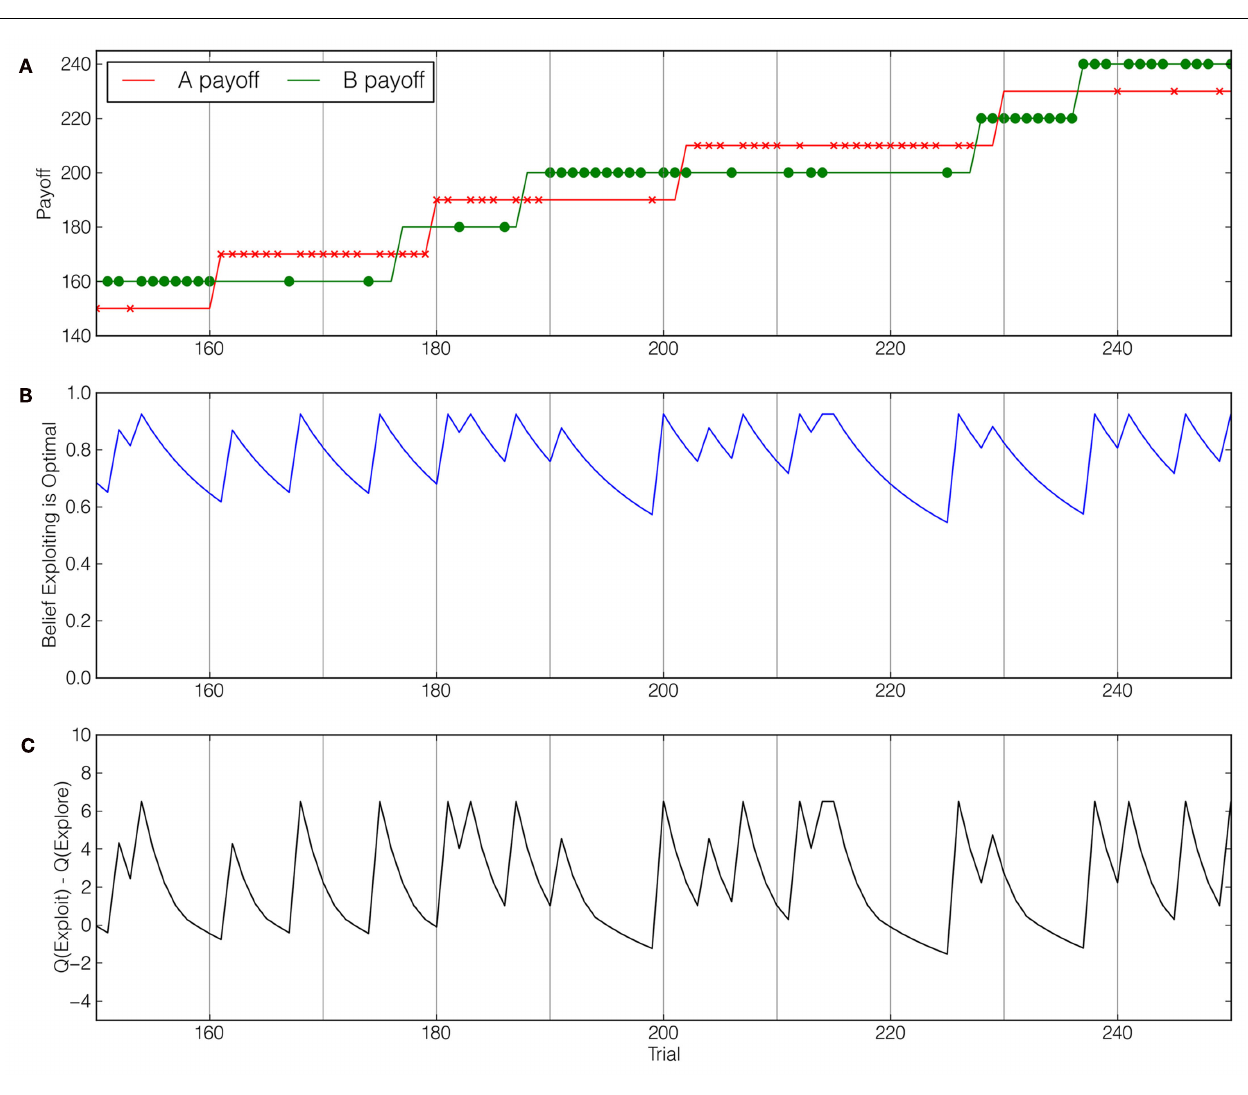
FIGURE 1 | Choice behavior and model-inferred beliefs and values in the Leapfrog bandit task. At each trial, there is a fixed probability, which we refer to as volatility or P (flip), that the inferior action increases its point payoff by 20 points. After the first “jump,” Action A “pays” 30 points, superior to Action B’s 20 points. After this jump, Action B’s payoff will increase by 20 points with the same probability. (A) An example participant’s sequence of choices over 100 trials in an environment with volatility rate P (flip) = 0.075.The two solid lines indicate the true payoffs for each option, and the × and • marks indicate the participant’s choices